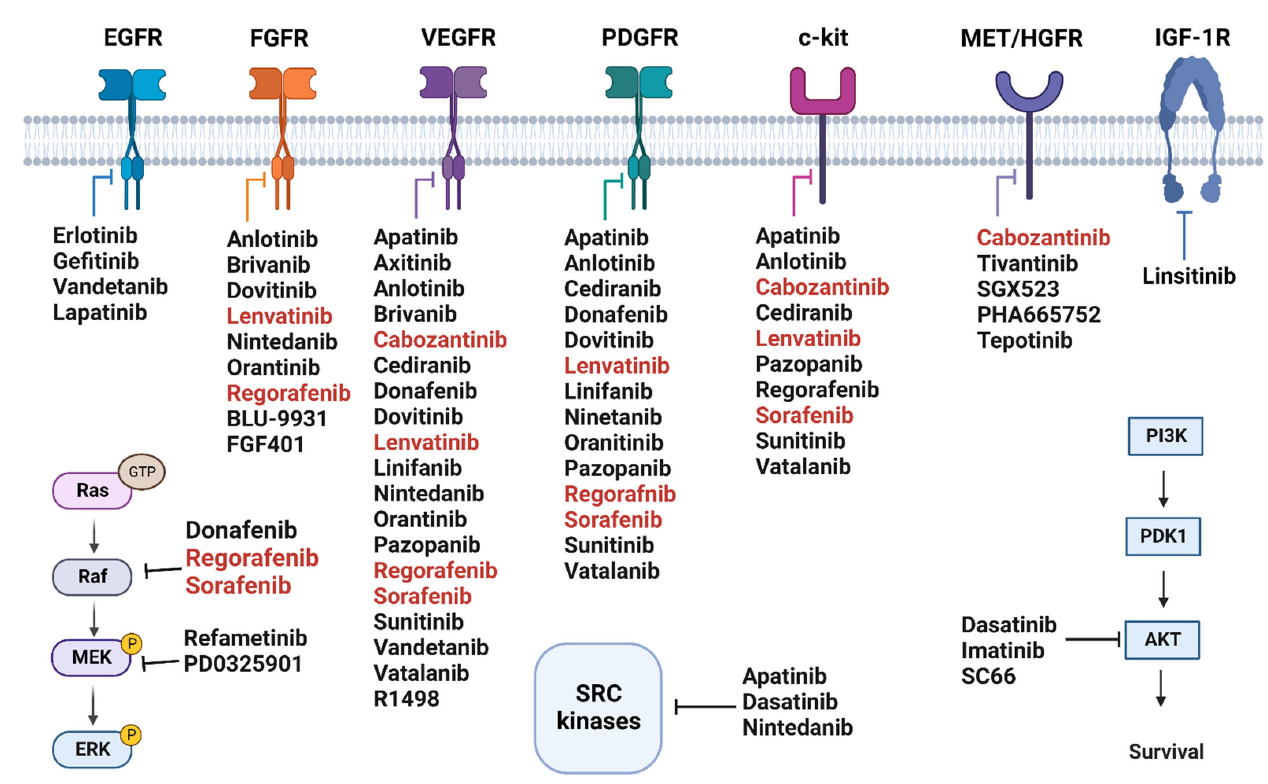
Figure 5. Schematic representations of FDA approved (indicated in red) and not licensed (indicated in black) small molecule inhibitors of tyrosine kinase receptors and other pathways in HCC discussed in this review. This figure was generated by biorender. EGFR, Epidermal Growth Factor Receptor; FGFR, Fibroblast Growth Factor Receptor; VEGFR, Vascular Endothelial Growth Factor Receptor; PDGFR, Platelet Derived Growth Factor Receptor; HGFR, Hepatocyte Growth Factor Receptor; IGF, Insulin Growth Factor Receptor.